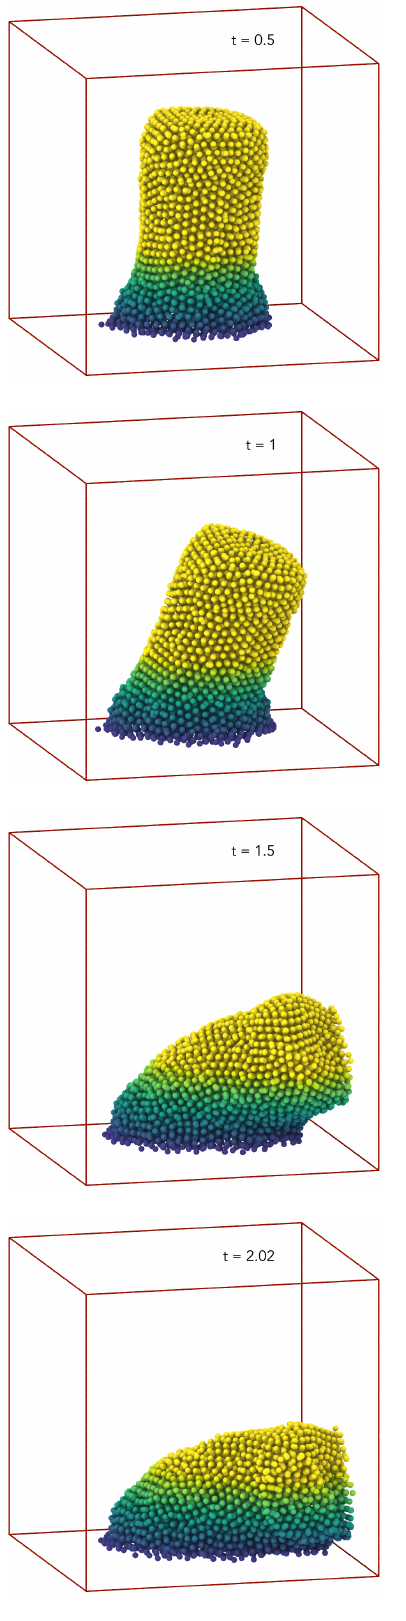
Figure 37. Time evolution of a cylindrical column of a viscoelastic substance in a non-symmetrical fashion. Substance settings: (cid:101) CS = 1 × 10 − 4 , (cid:101) Soft = 0.2 (cid:101) CS , ρ = 1000, c = 10.0, ν artf =